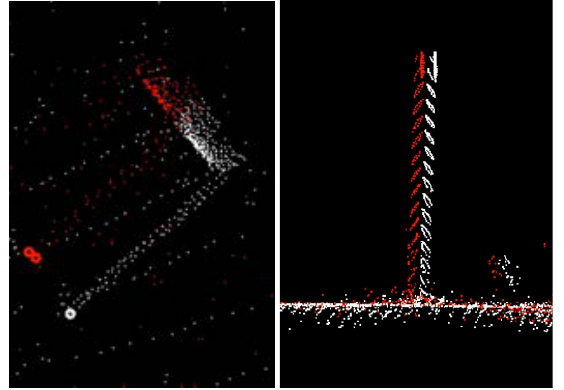
Figure 3. Horizontal positional error between point cloud’s multi-passes